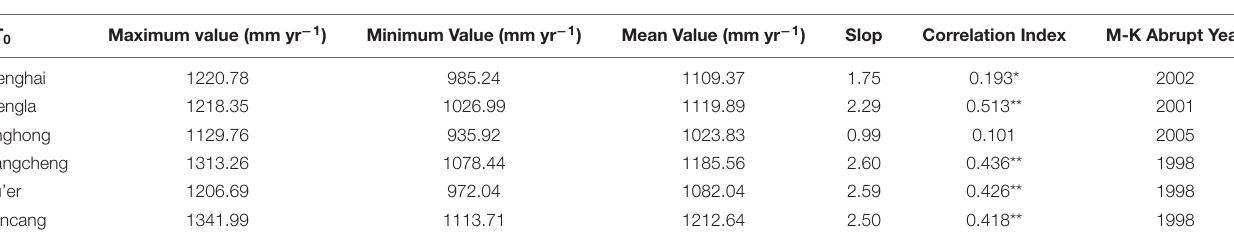
FIGURE 5 | Interannual variation (A) and Manne-Kendall (M-K) mutation analysis (B) of ET 0 in Xishuangbanna. TABLE 2 | Interannual variation analysis of ET 0 at each station in